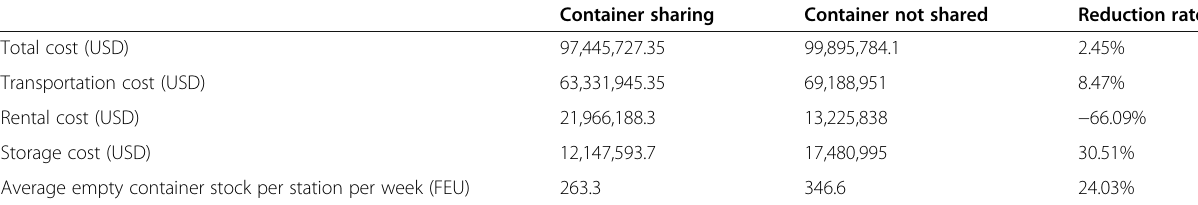
Table 5 Comparison of container sharing and non-sharing